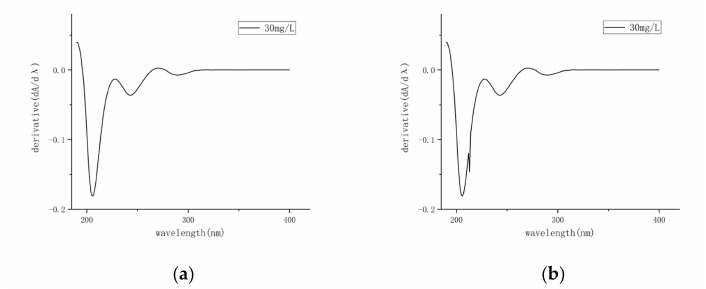
Figure 10. ( a ) The first derivative spectrum of COD solution after smoothing; ( b ) The first derivative spectrum of COD solution after unsmoothing.